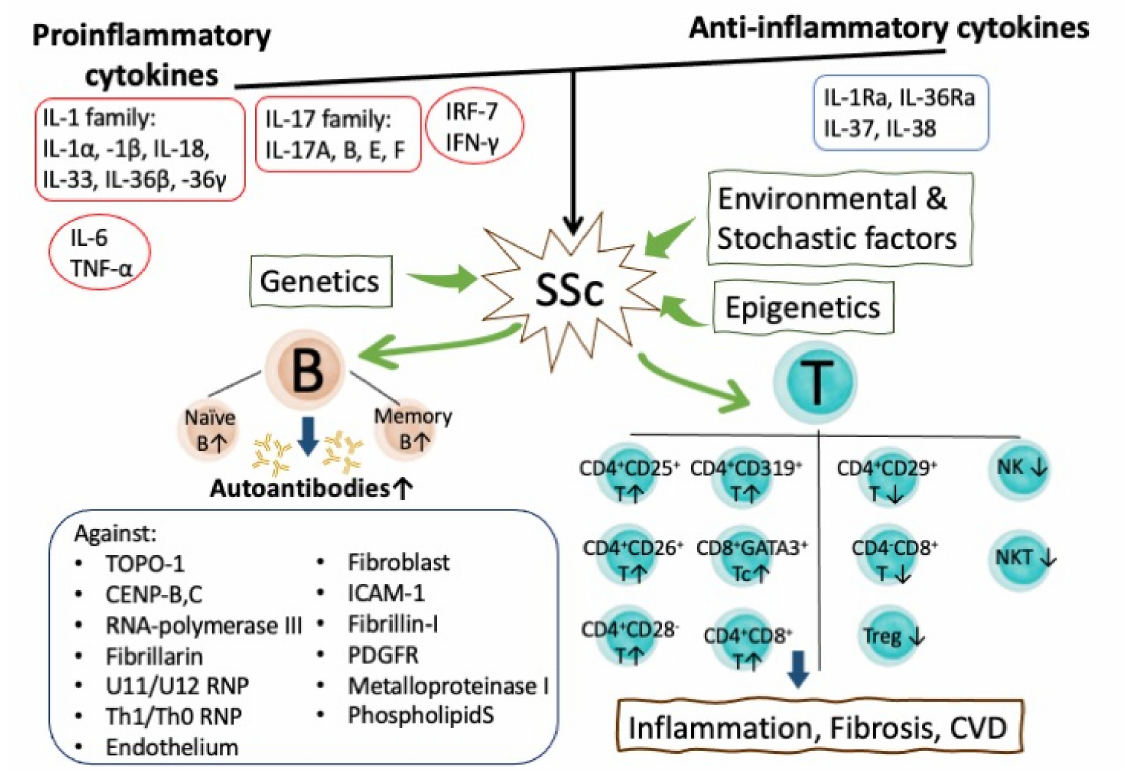
Figure 6. The roles of imbalanced proinflammatory/anti-inflammatory cytokines and deranged ontoge- netic/immunobiological development of B and T lymphocytes in the induction of inflamm-aging of patients with SSc. The autoantibodies and abnormal T cell responsiveness are the two essential pathological factors for eliciting tissue inflammation, fibrosis, and cardiovascular complications in these patients. PDGF: platelet-derived growth factor; Tc: cytotoxic T cell; Treg: regulatory T cell; NK: natural killer cells; NKT: natural killer T